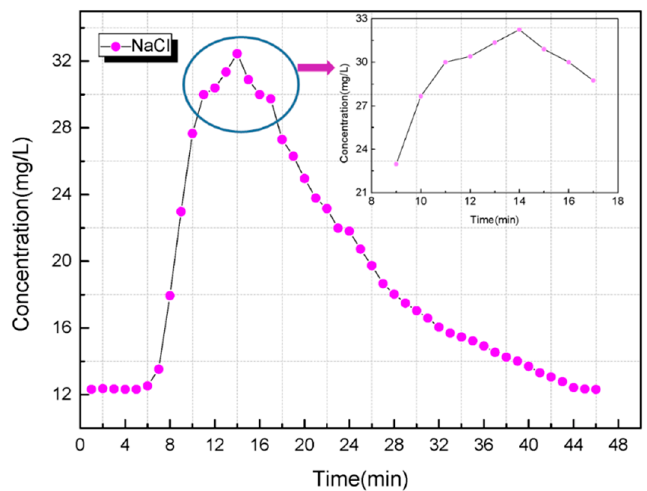
Figure 6. The NaCl concentration–time curve of D1.